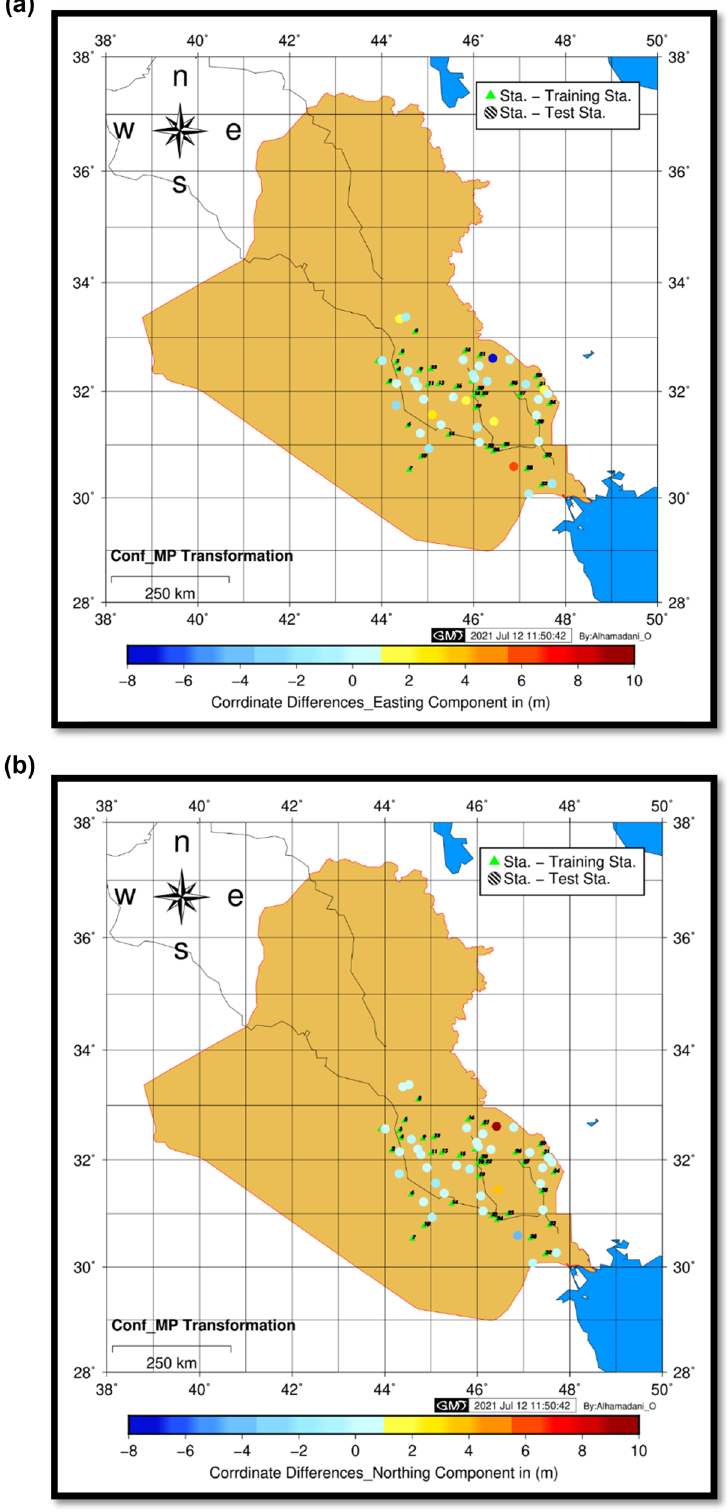
Figure 9: ( a ) Color scale accuracy for the 2D conformal method for easting. ( b ) Color scale accuracy for the 2D conformal method for